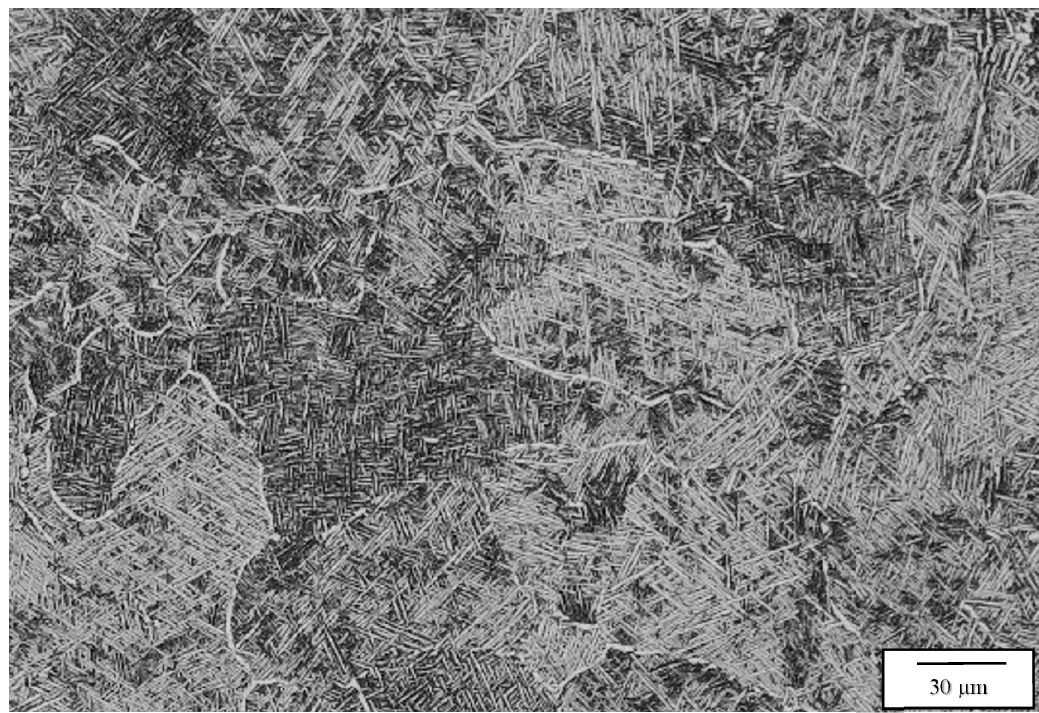
Figure 8. Variant 3 image for the Arcam A2X bottom section, X plane.